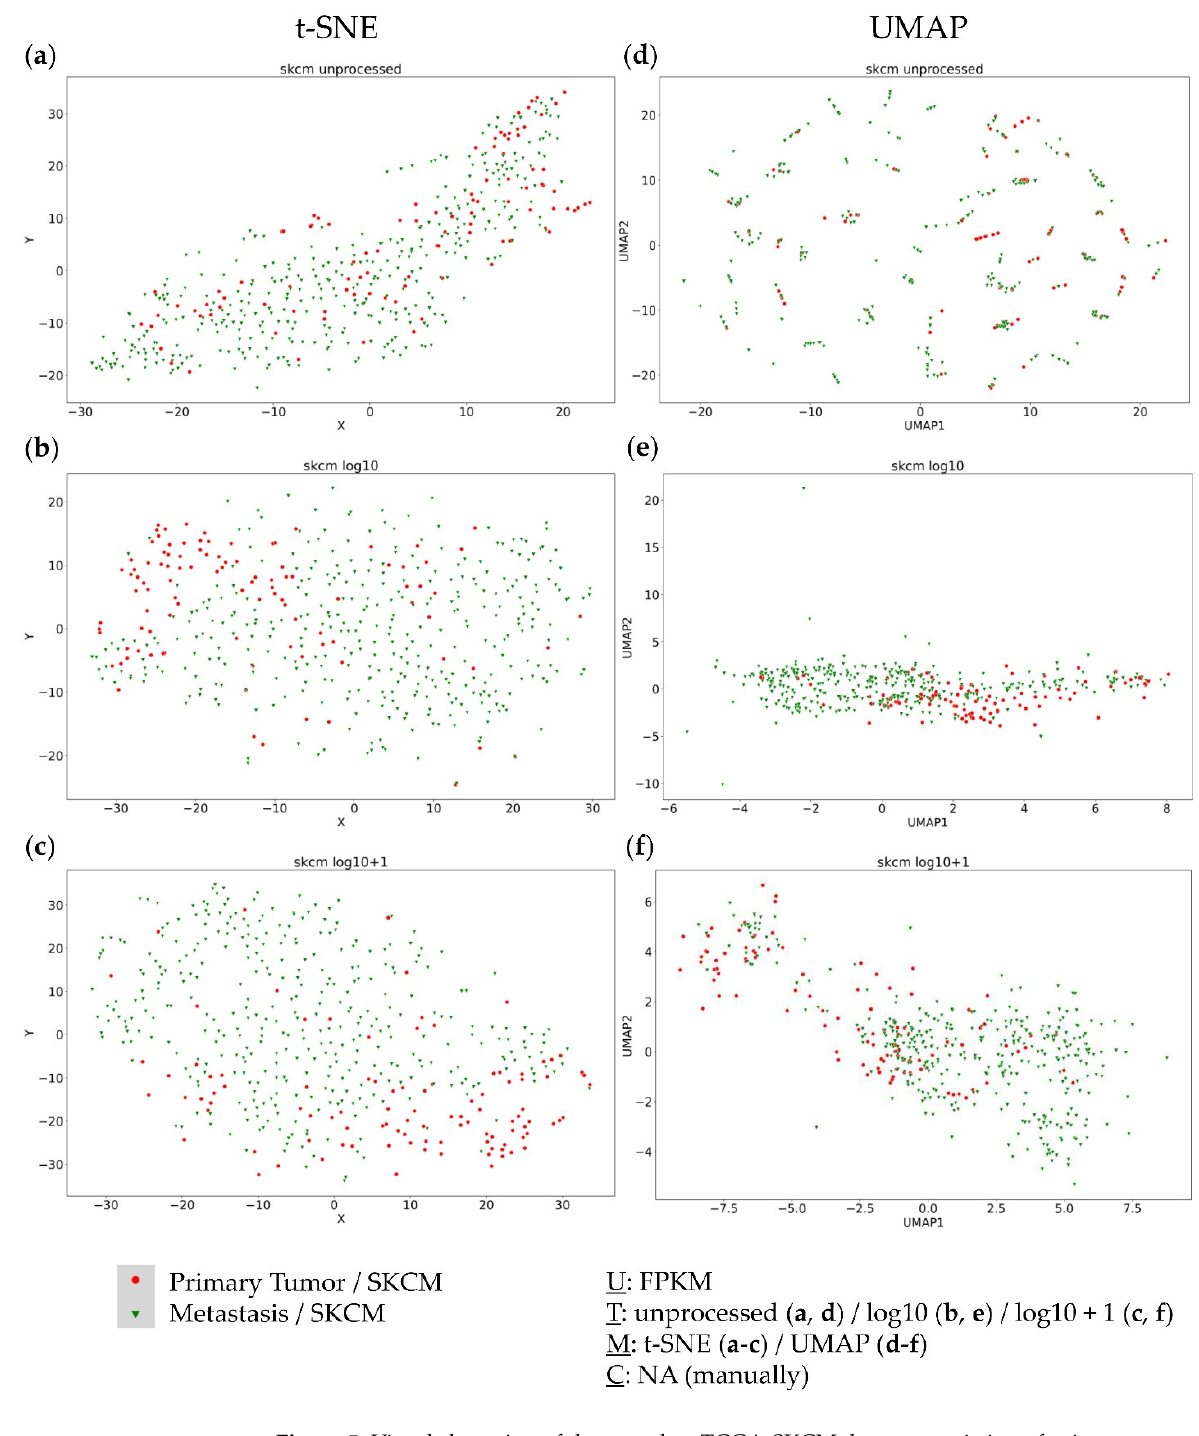
Figure 5. Visual clustering of the complete TCGA-SKCM dataset consisting of primary tumors (red) and metastases (green) by applying different data dimension reduction methods. t-SNE plot approach for ( a ) unprocessed, ( b ) log10 transformed, and ( c ) log10 + 1 transformed FPKM values and UMAP approach using ( d ) unprocessed, ( e ) log10 transformed, and ( f ) log10 + 1 transformed FPKM values. FPKM: Fragments Per Kilobase Million; U: unit, T: transformation, M: data dimension reduction method, C: clustering method, NA: not applicable.